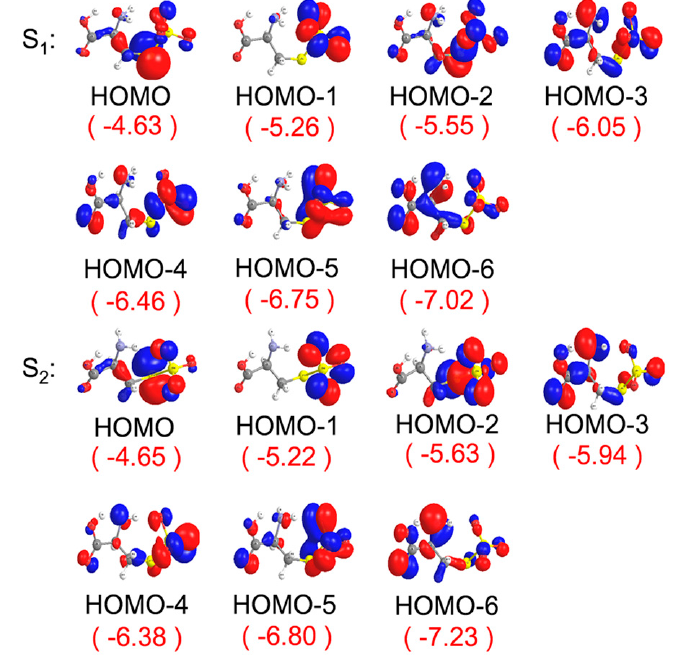
Figure 4. Molecular orbital (MO) analysis for conformers S 1 and S 2 of the cysteine perthiosulfonate anion [cysS-SO 3 ] − . The MO energy levels are shown in parentheses (in eV).